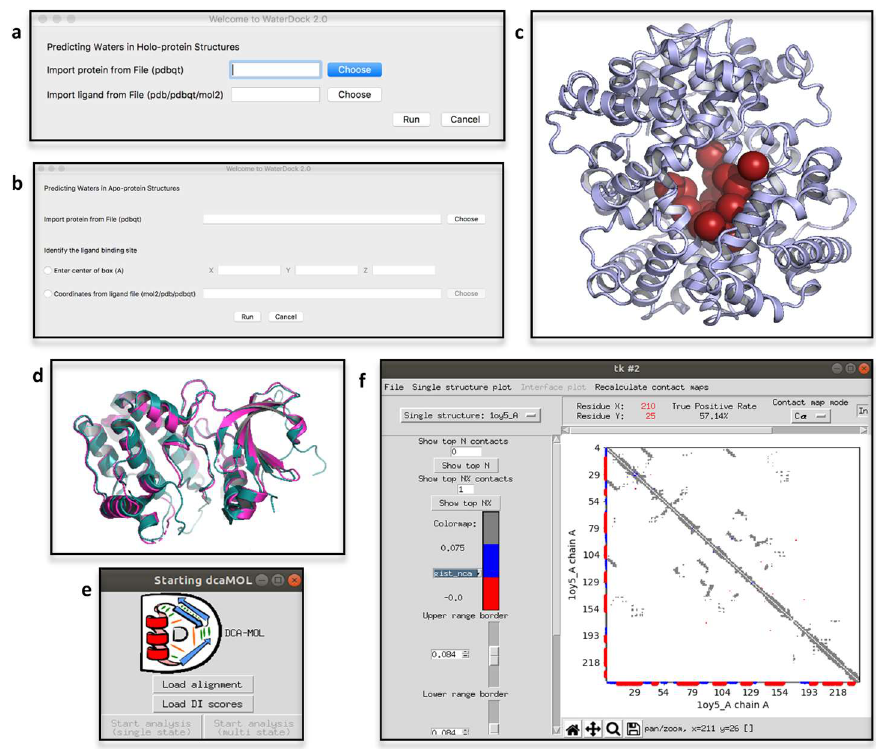
Figure 2. Waterdock 2.0 GUI (mac OS version) for the analysis of the position of water binding sites on holo-( a ) or apo-( b ) protein structures. Waterdock was tested with inputs available on the plugin development web-resource (https://github.com/bigginlab/WaterDock_pymol; accessed on 22 November 2022). ( c ) Waterdock rendering of the identified water molecules positions in PyMOL. ( d ) Example of PyMOL rendering of the pairwise structural alignment of two protein structures (i.e., Aurora-A kinase in two different conformations; PDB-ID: 1OL5 and 1OL6 [36]) obtained by iPBAvizu. ( e ) Starting window of DCA-MOL, from which alignments and DI-scores can be imported. ( f ) Example of a contact map obtained from DCA-MOL. Input files available on the plugin development web-resource.